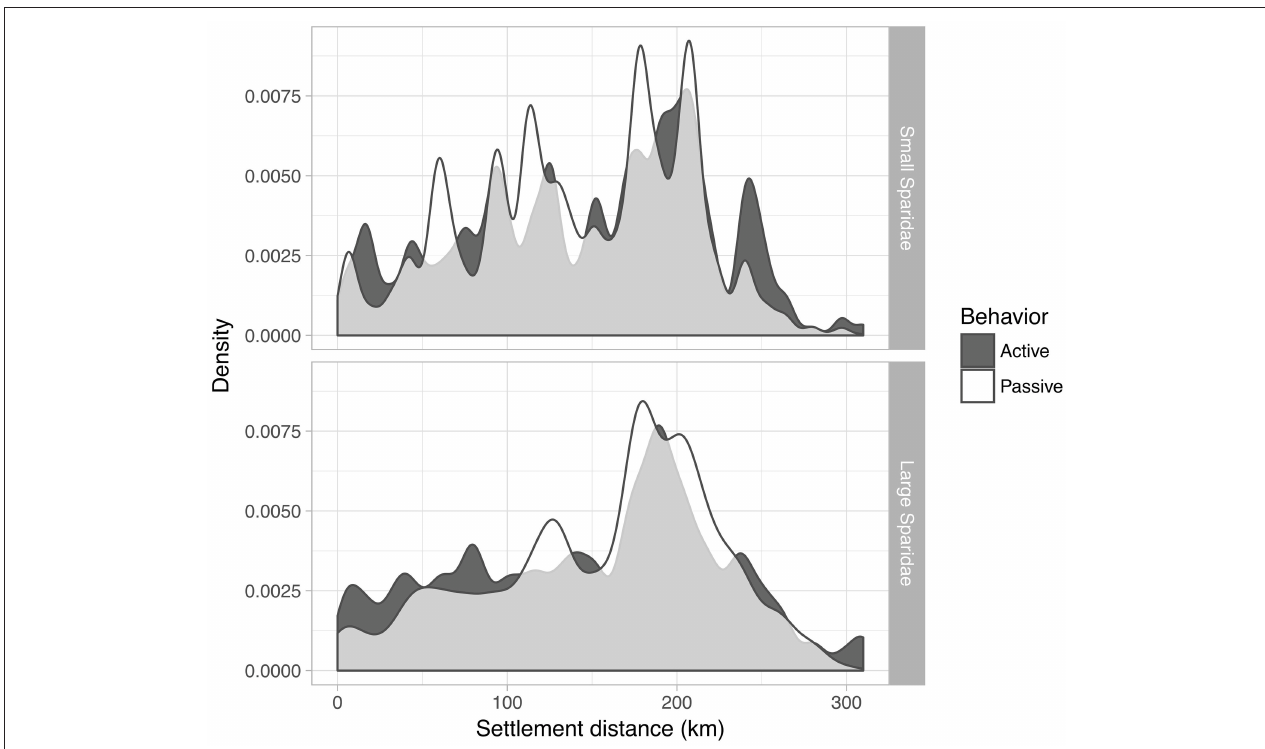
FIGURE 6 | Dispersal kernels for the two groups of Sparidae and the two simulation configurations, i.e., kernel density smoothing of distances from the release site to the settlement site.